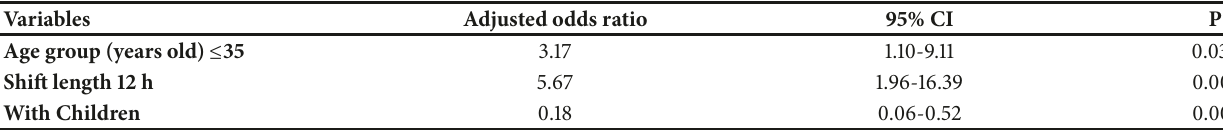
Table 7: Logistic regression analysis of factors associated with gender